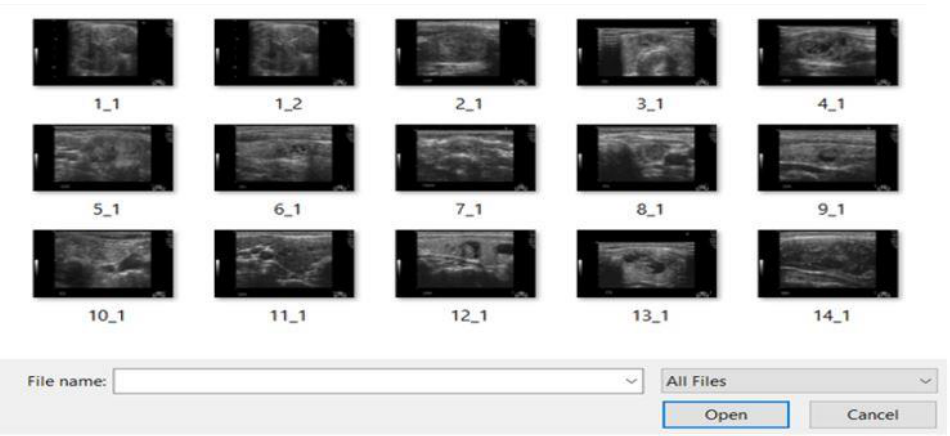
Figure 12. GUI prompt.